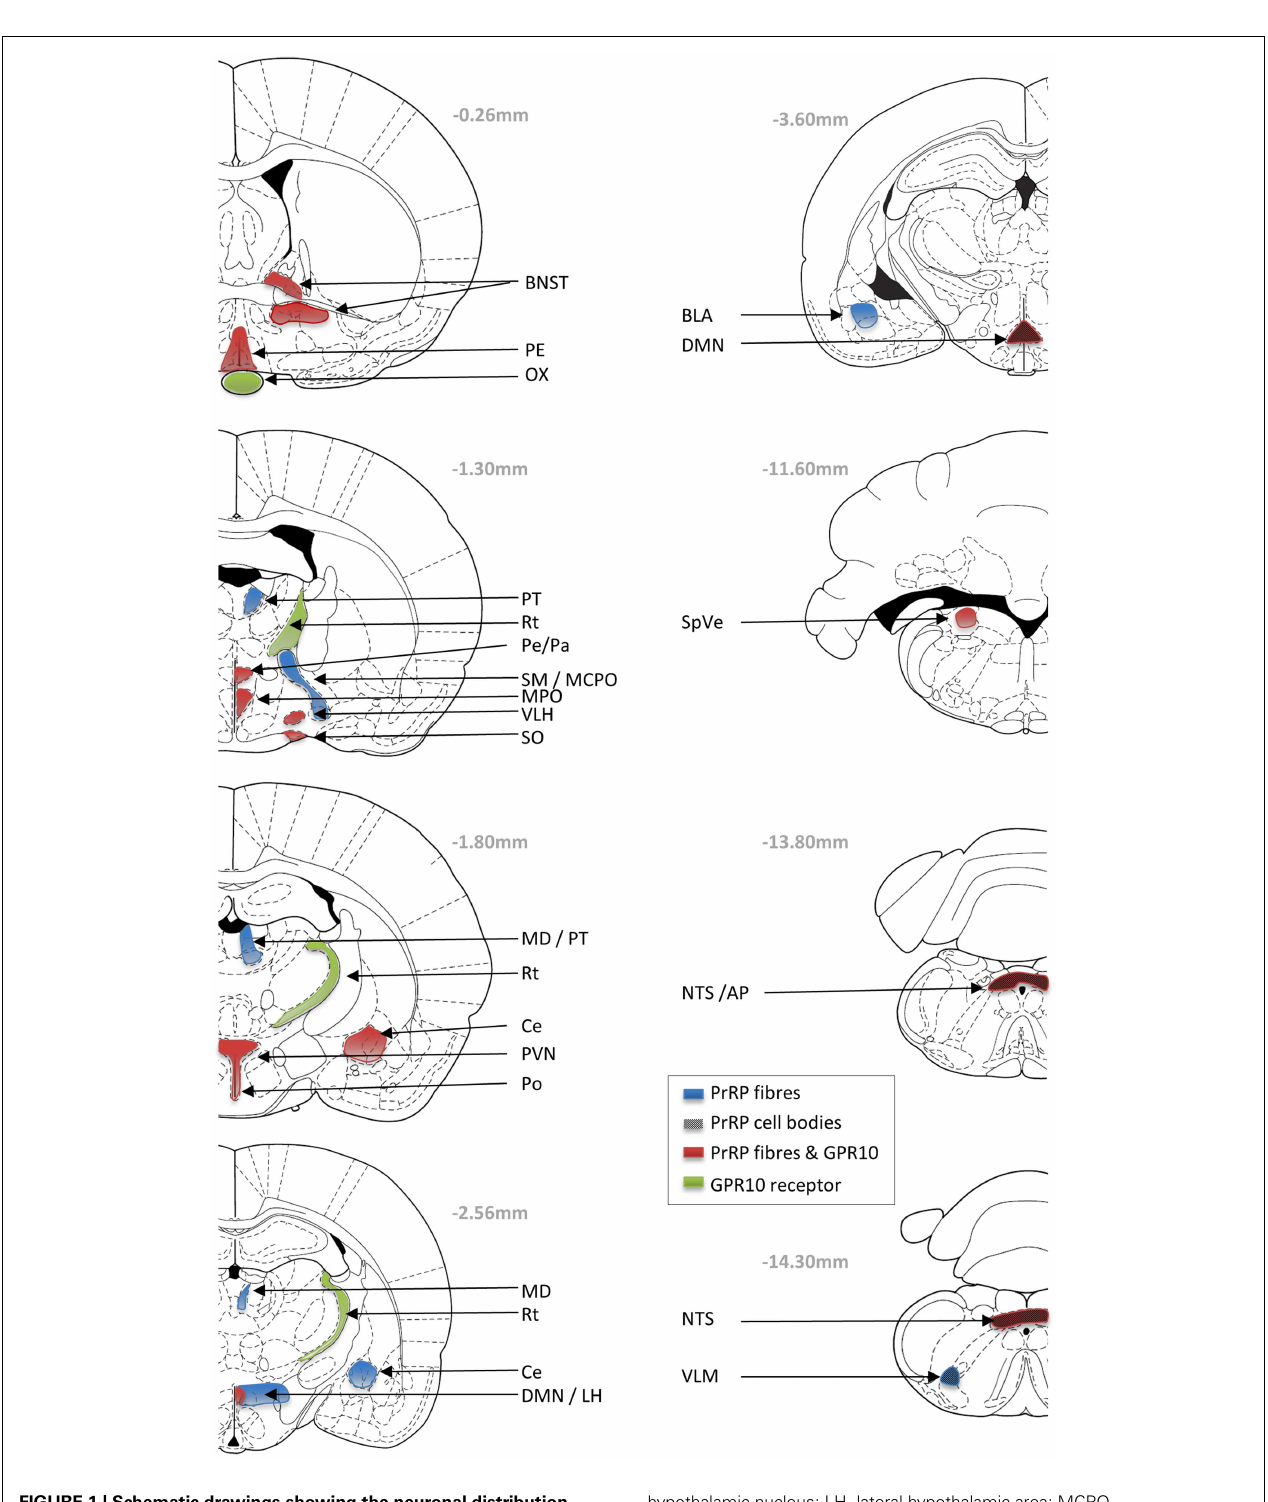
FIGURE 1 | Schematic drawings showing the neuronal distribution of PrRP and GPR10 receptor in the Paxions andWatson rat brain atlas (Paxinos andWatson, 1998; Sun et al., 2005). Blue areas represent PrRP-immunopositive nerve fibers; black checkers represent PrRP cells bodies; green areas represent GPR10 expression; and red areas represent overlap of PrRP and GPR10 expression. AP, area postrema; BL, basolateral amygdaloid nucleus; BNST, bed nucleus of the stria terminalis; Ce, central amygdaloid nucleus; DMN, dorsomedial